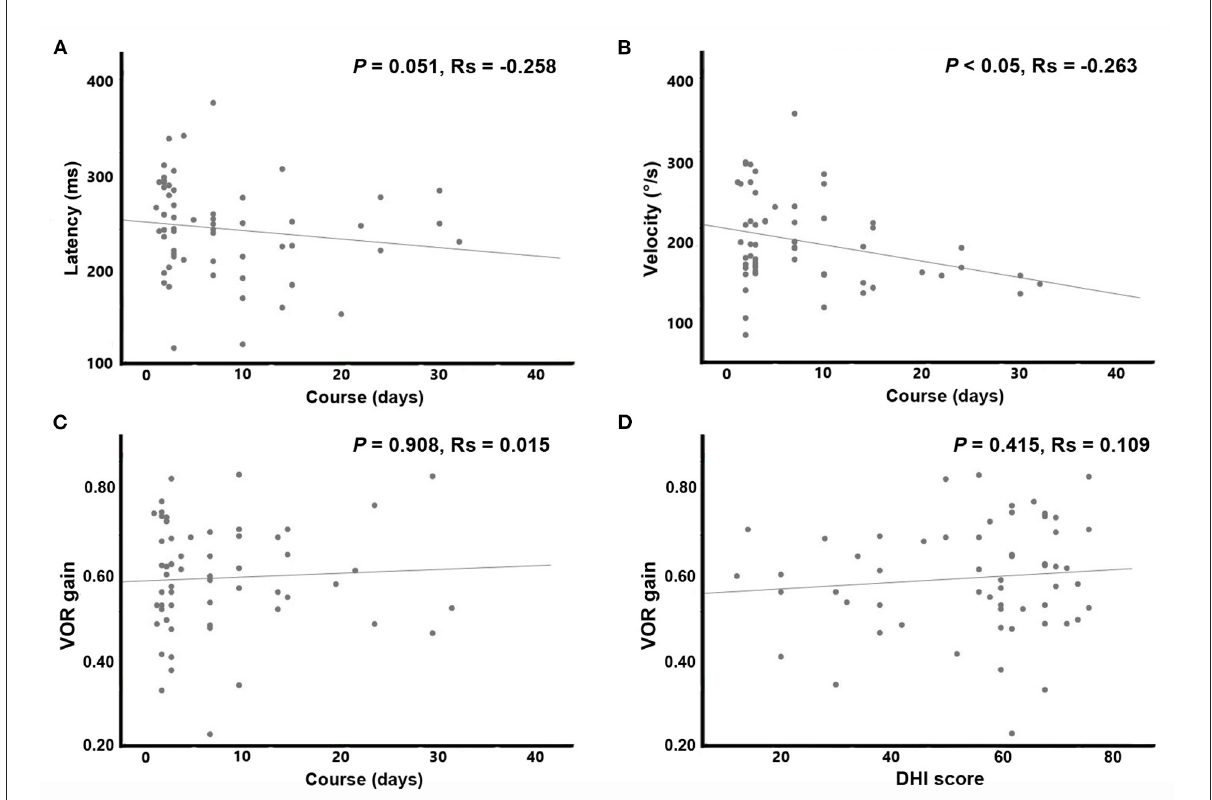
FIGURE3 Scatterplots and results of Spearman correlation. With a longer disease course, the velocity of overt saccade was smaller ( p < 0.05, Rs = − 0.263) in patients with VN. (A) Abscissa: disease course (days); ordinate: latency of overt saccades (ms). (B) Abscissa: disease course (days); ordinate: velocity of overt saccades ( ◦ /s). (C) Abscissa: disease course (days); ordinate: VOR gain. (D) Abscissa: DHI score (points); ordinate: VOR